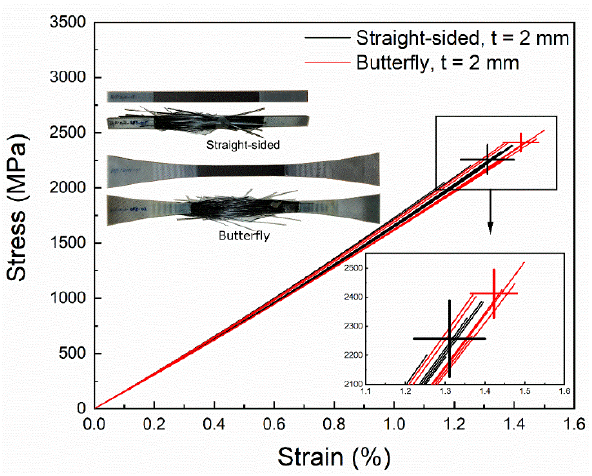
Figure 1. Stress–strain curves of straight-sided (black curves) and butterfly (red curves) test specimens. The crosses (+) at the end of the curves represent standard deviations of failure stress and strain to failure. The inset shows pictures of the test specimens before and after the test.